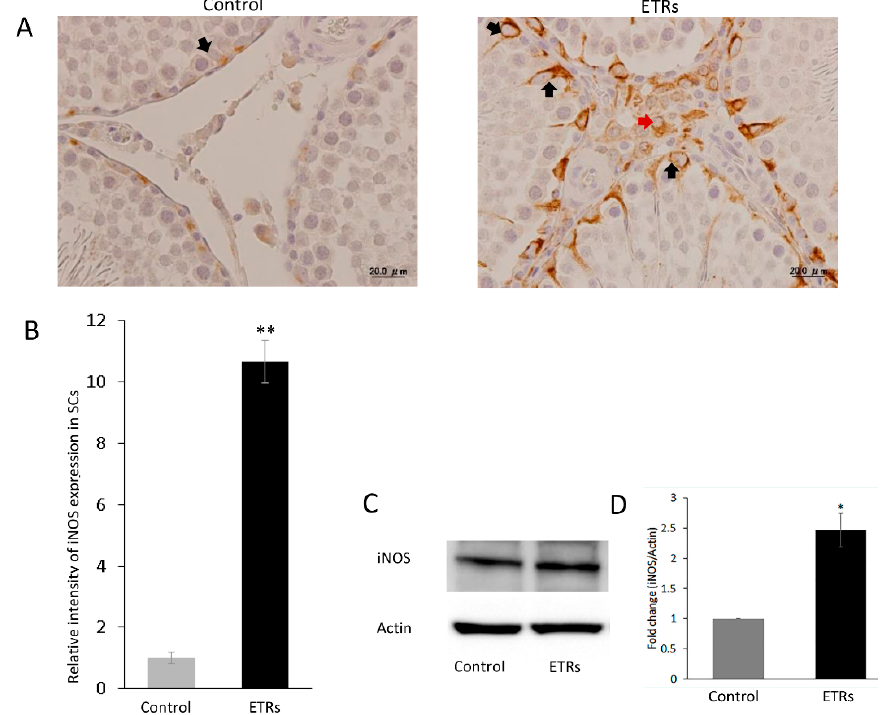
Figure 10. Upregulation of iNOS in ETR SCs. ( A ) IHC of iNOS in control and ETRs. Note the enhanced expression in SCs (black arrows) and interstitial cells (red arrows) of ETRs. ( B ) Quantification of iNOS expression in SCs. ** p < 0.01 ( t -test). ( C ) Western blot of iNOS expression in control and ETR testes ( n = 3). ( D ) Histogram demonstrating higher iNOS expression in ETR testes compared to the control. * p < 0.05 (t-test).